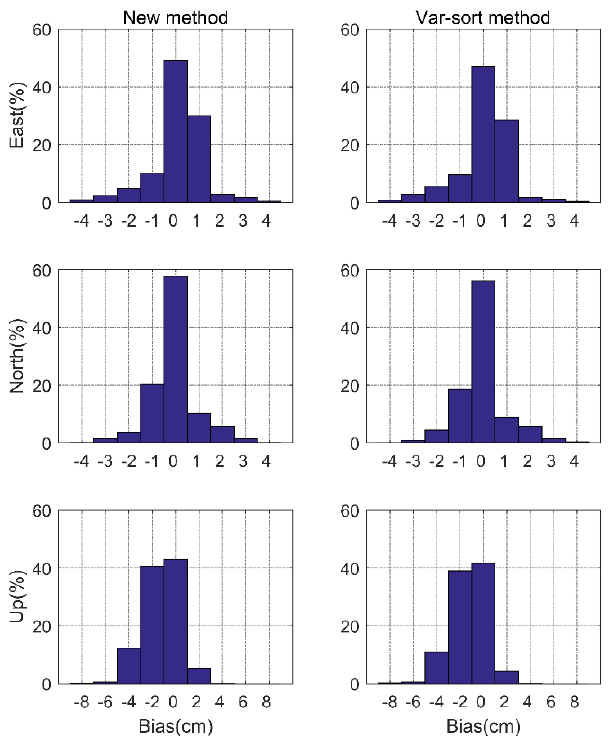
Figure 3. Histogram of coordinate residual distribution for different optimal subset selection methods for PAR. Table 2. Number of epochs of partial ambiguity resolution for each station under two optimal subset selection schemes.